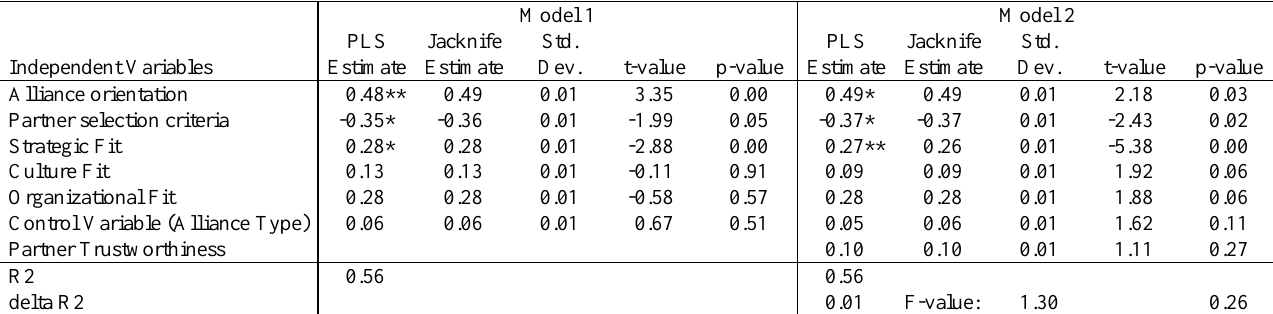
Table 4: PLS analysis